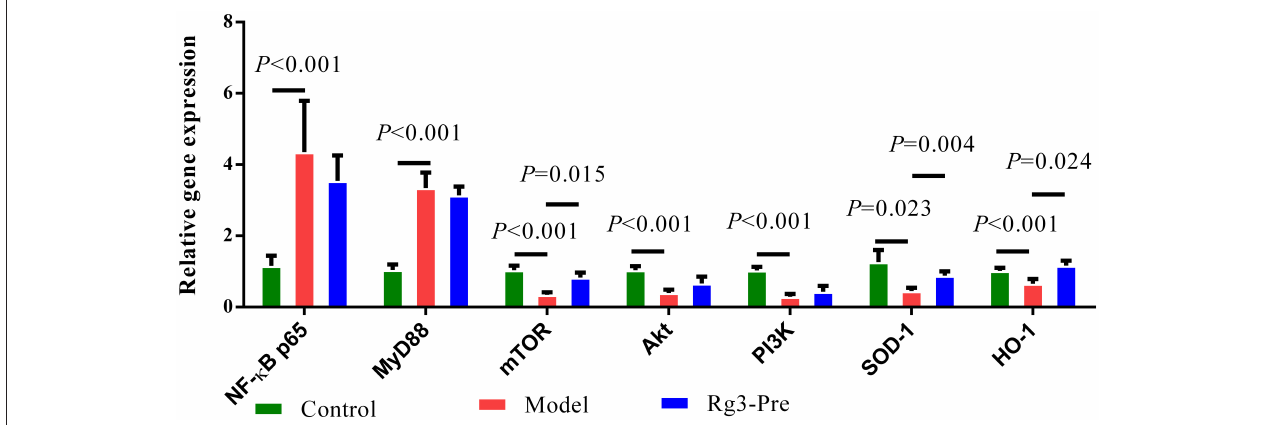
FIGURE 5 | Relative mRNA expression in the liver. Total RNA was extracted from the liver. The Chicken β -actin was served as the internal control gene. Expression of nuclear factors kappa B (NF- κ B) p65, myeloid differential protein-88 (MyD88), mammalian target of rapamycin (mTOR), AKT serine-threonine kinase 1 (Akt), phosphoinositol 3 kinase (PI3K), and SOD-1 mRNA were assessed by real-time quantitative PCR. A relative quantitative method (2 − 11 CT ) was employed to evaluate the quantitative variation. Data are represented as means ± SE ( n =